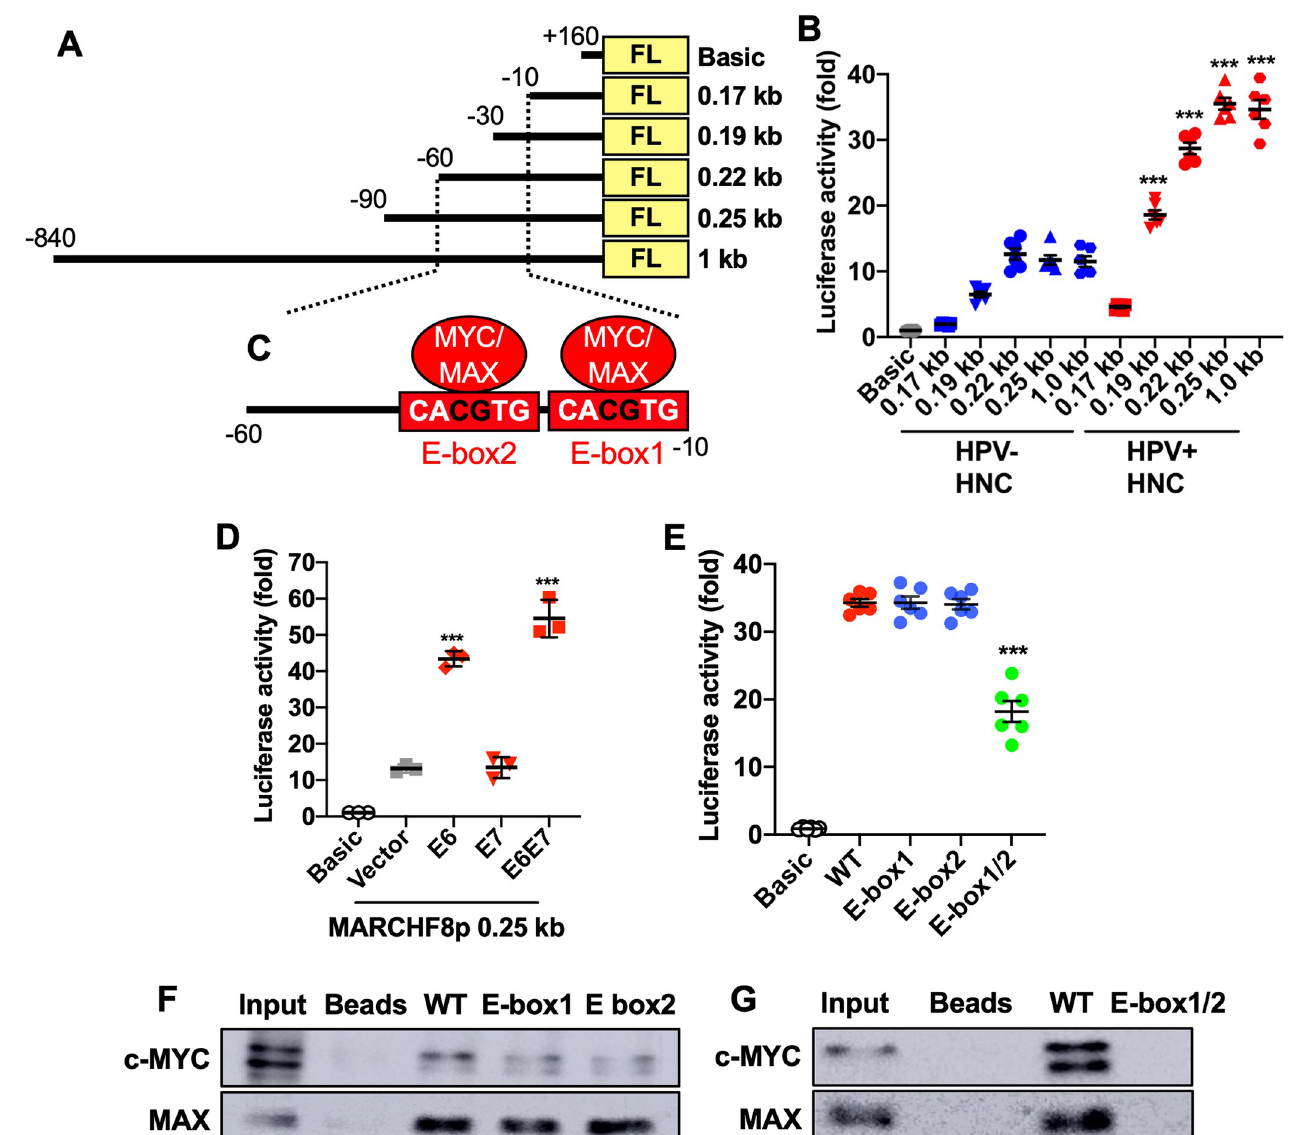
Fig 2. The HPV oncoprotein E6 induces the MARCHF8 promoter activity mediated by the MYC/MAX complex. Schematic representation of the MARCHF8 promoter regions (-840 to +160) in the firefly luciferase (FL) reporter plasmid pGL4.2 ( A ) and two E-boxes ( C ). The promoter-reporter constructs were transfected into HPV+ (SCC152) and HPV- (SCC1) cells ( B ) and cotransfected into SCC1 cells with HPV16 E6, E7, or E6 and E7 expression plasmids ( D ). SCC152 cells were transfected with the 0.25 kb promoter (-90 to +160) reporter constructs of wildtype (WT) and E-box mutants containing single or double CG deletion in E-box1, E-box-2, and E-box1/2 ( B and E ). Luciferase activity was measured 48 h post transfection. Representative data from three independent experiments are shown as a fold change relative to the empty pGL4.2 vector (Basic). Shown are representative data of three repeats. P values were determined by Student’s t -test. � p < 0.05, �� p < 0.01, ��� p < 0.001. A DNA-protein pulldown assay was performed using biotinylated 90 bp oligonucleotides containing wildtype or E-boxes mutants (-85 to +5) incubated with nuclear extracts from SCC152 cells. The DNA-bound proteins were analyzed using anti-c- MYC and MAX antibodies ( F and G ) by western blotting. To identify the cellular factors that bind to the essential MARCHF8 promoter regions (-60 to -10) in the context of HPV16 E6, we performed a DNA-protein pulldown assay using bioti- nylated 90 bp oligonucleotides containing the promoter sequence between -85 and +5. Our liquid chromatography-mass spectrometry identified 83 MARCHF8 promoter-binding pro- teins ( S2 Table ). Our in silico analysis using the Eukaryotic Promoter Database (epd.epfl.ch)